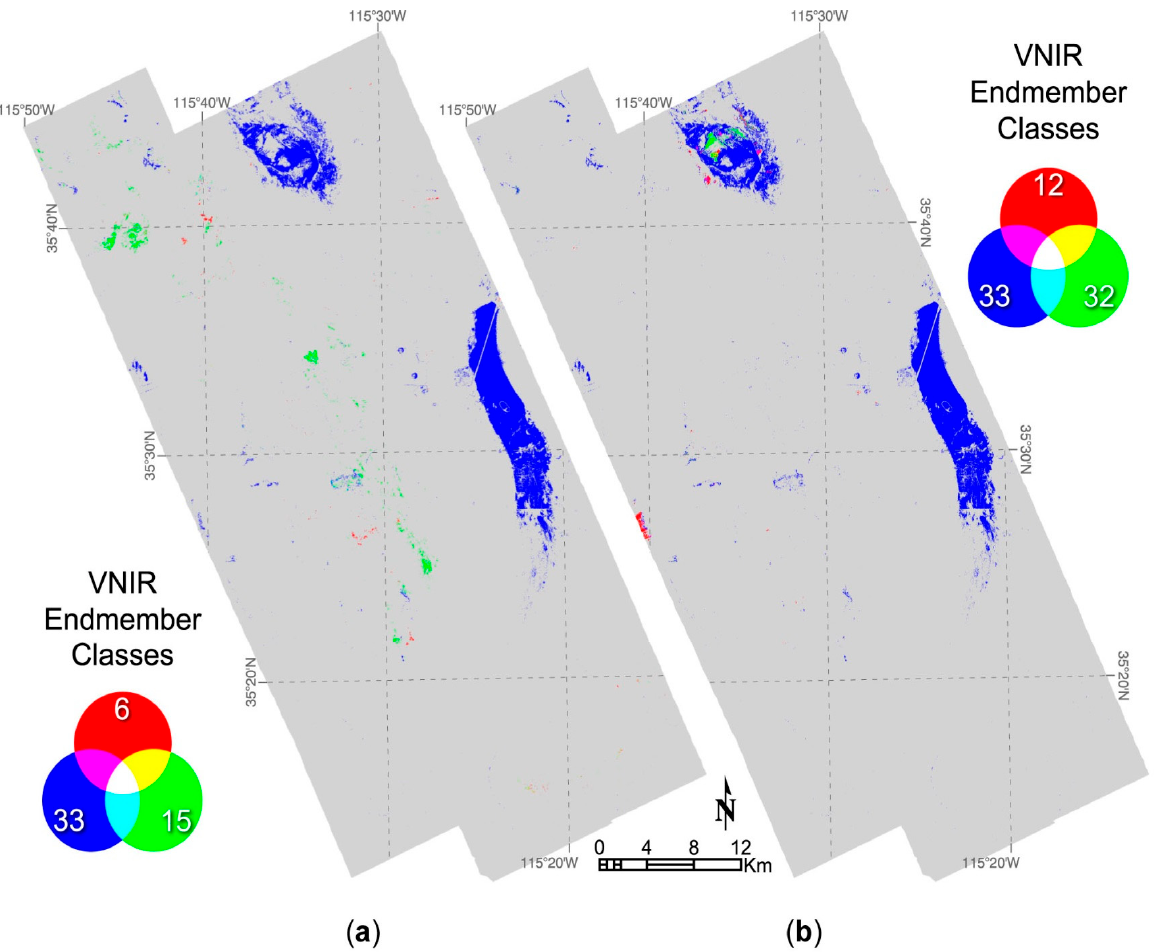
Figure 6. False color composite images of selected visible to near infrared (VNIR) endmember classes: ( a ) 6/15/33 in red/green/blue; ( b ) 12/32/33 in red/green/blue. Pixels with approximate abundance values less than 40% for the selected endmembers are masked in gray.